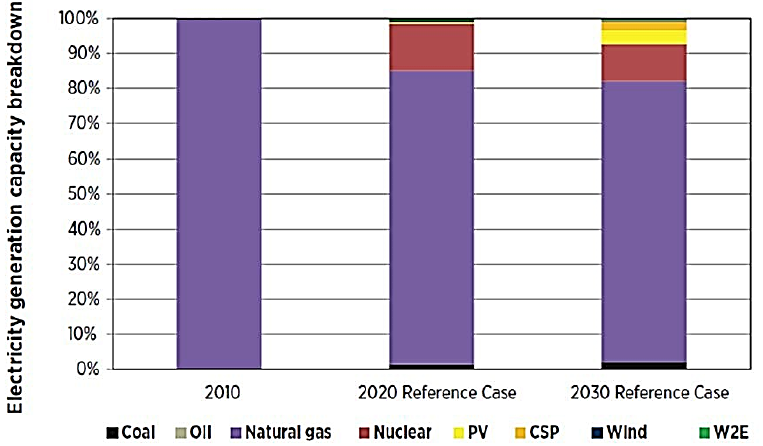
Figure 10. Referred growth rate of renewable energy capacity in the UAE. Reprinted with permission from Ref. [64].